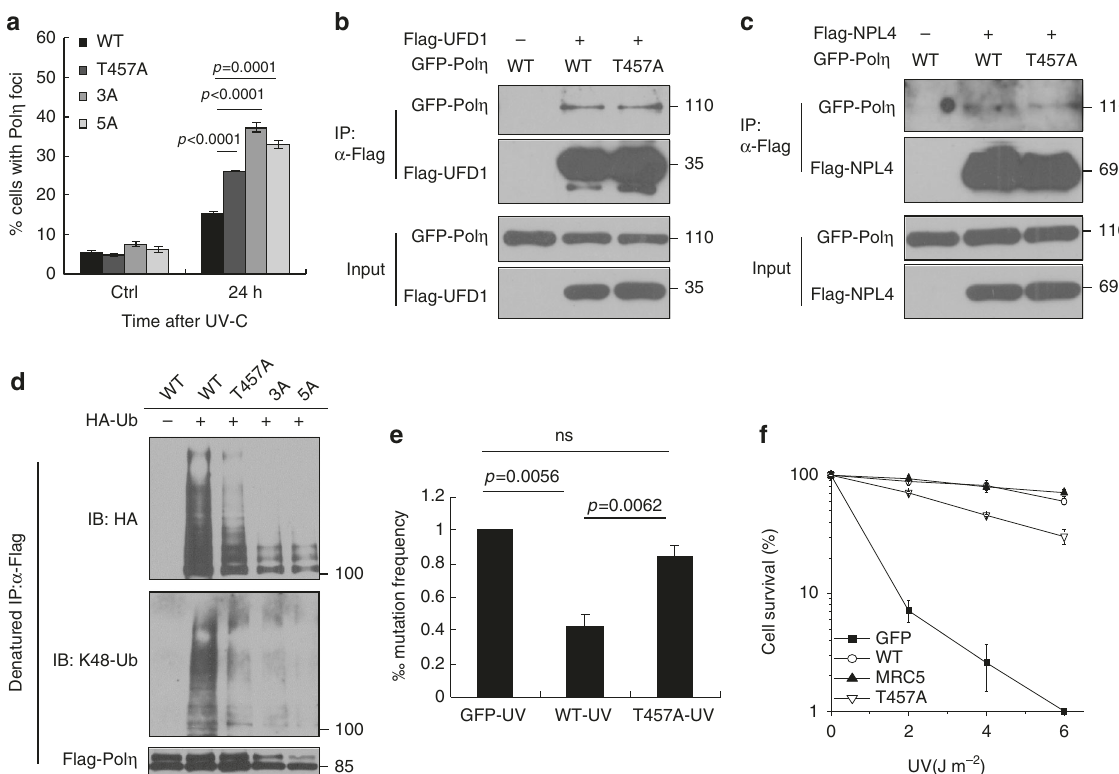
Fig. 3 T457A impairs Pol η removal from chromatin after UV irradiation. a U2OS cells transfected with WT or mutated GFP-Pol η constructs were irradiated with UVC (15 J m − 2 ) and further incubated for 24 h. The proportions of GFP-Pol η -expressing cells with > 30 foci were determined. Data represent means ± SEM from three independent experiments. b , c Flag-UFD1 b or Flag-NPL4 c and GFP-Pol η (WT or T457A) were transfected into 293T cells. The lysates were immunoprecipitated using anti-Flag M2 beads. The inputs and immunoprecipitates were examined via western blotting using anti-GFP and anti-Flag antibodies. d 293T cells were transfected with WT or mutant Flag-Pol η as well as HA-Ub or HA empty vector. The cell lysates were immunoprecipitated with anti-Flag M2 beads under denaturing condition, followed by immunoblotting with anti-HA, anti-K48-Ubiquitin, and anti-Flag antibodies. e Mutation frequency in damaged (400 J m − 2 UVC) supF plasmid was determined. Data represent means ± SEM from three independent experiments. ns not signi fi cant. f XP30RO cells stably expressing GFP, WT or T457A GFP-Pol η and MRC5 cells were irradiated with the indicated doses of UVC and further incubated in medium supplemented with 0.4 mM caffeine for 7 – 10 days. The number of cell clones was determined. Surviving fraction was expressed as a percentage of mock-treated cells. Experiment was repeated three times, giving similar results. The representative curve is shown. Error bar: s.d., n =